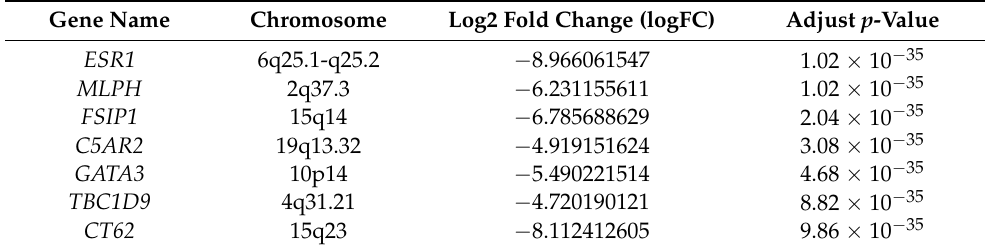
Table 1. Top 30 significantly differentially expressed genes distinguishing TNBC from